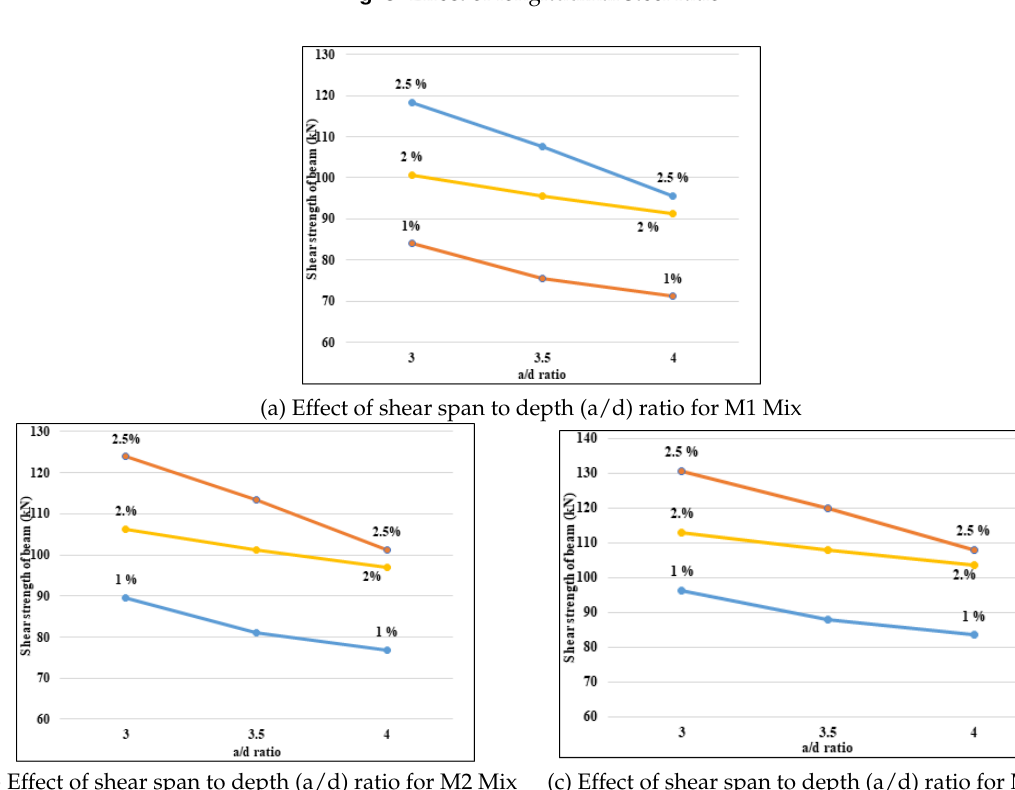
Fig. 4. Effect of shear span to depth (a/d)